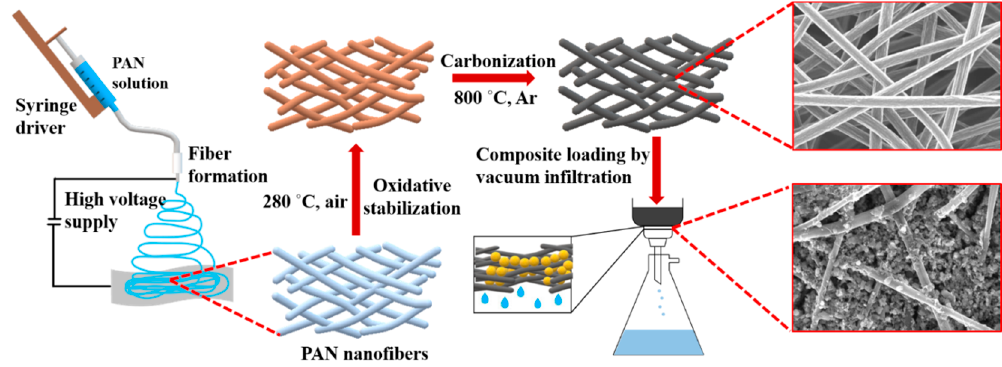
Figure 1. Scheme of carbon nanofiber fabrication and sulfur-based cathode preparation.